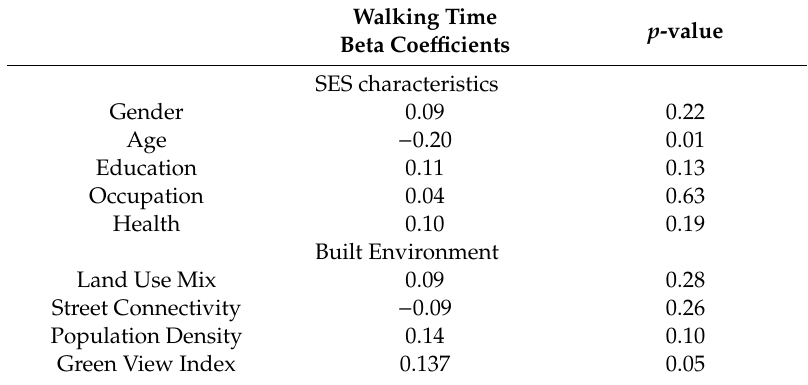
Table 4. The e ff ects of sociodemographic characteristics, built environment characteristics, and urban greenery on walking